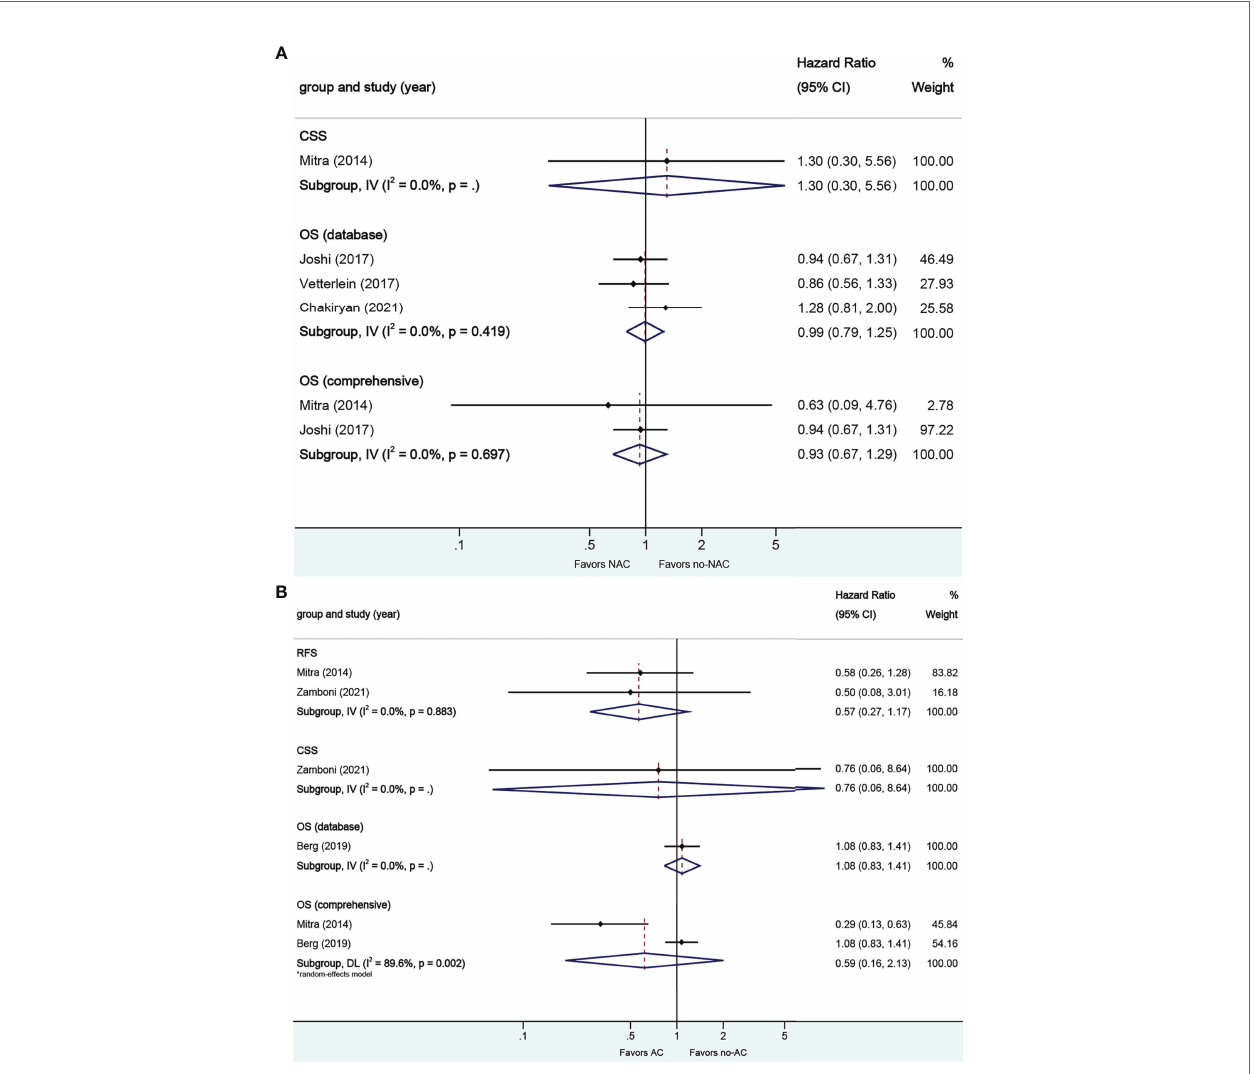
FIGURE 6 | Forest plots of studies investigating the association of chemotherapy with survival outcomes in glandular variant histology. (A) neoadjuvant chemotherapy; (B) adjuvant